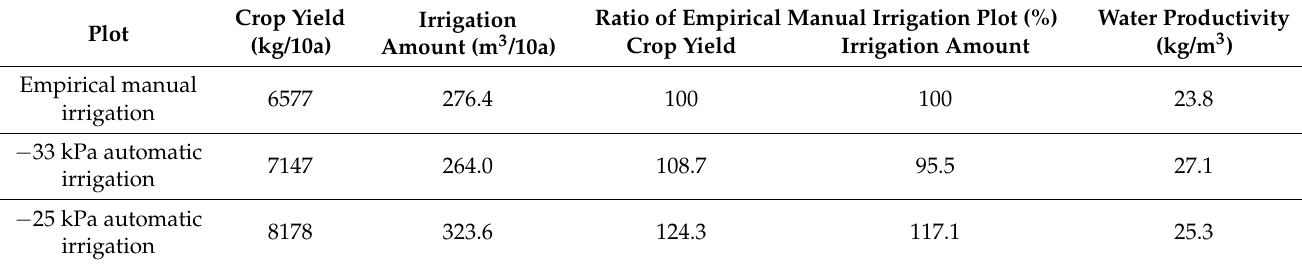
Table 2. Crop yield, irrigation amount, and water productivity by each plot in the first cropping